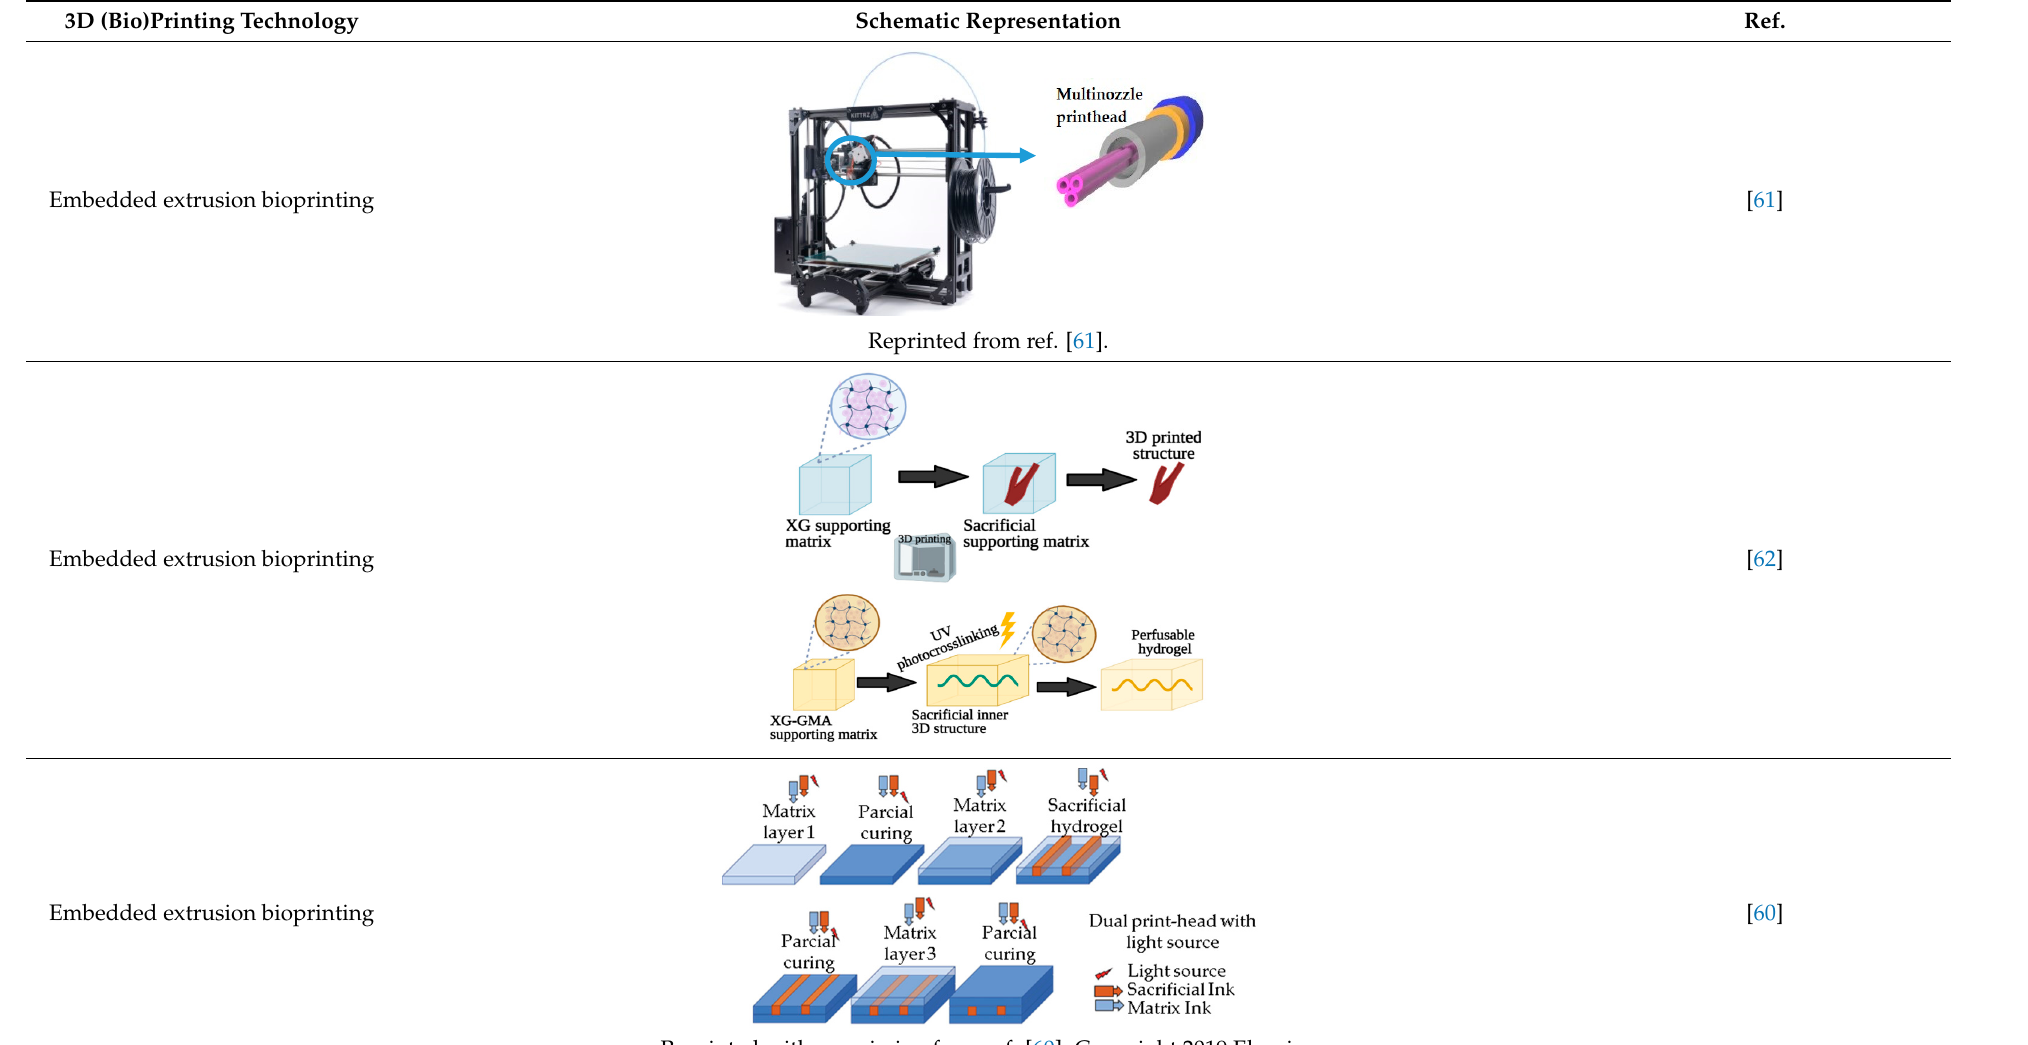
Table 3. Novel approaches of 3D bioprinting/printing techniques suitable for the manufacturing of OoC platforms.